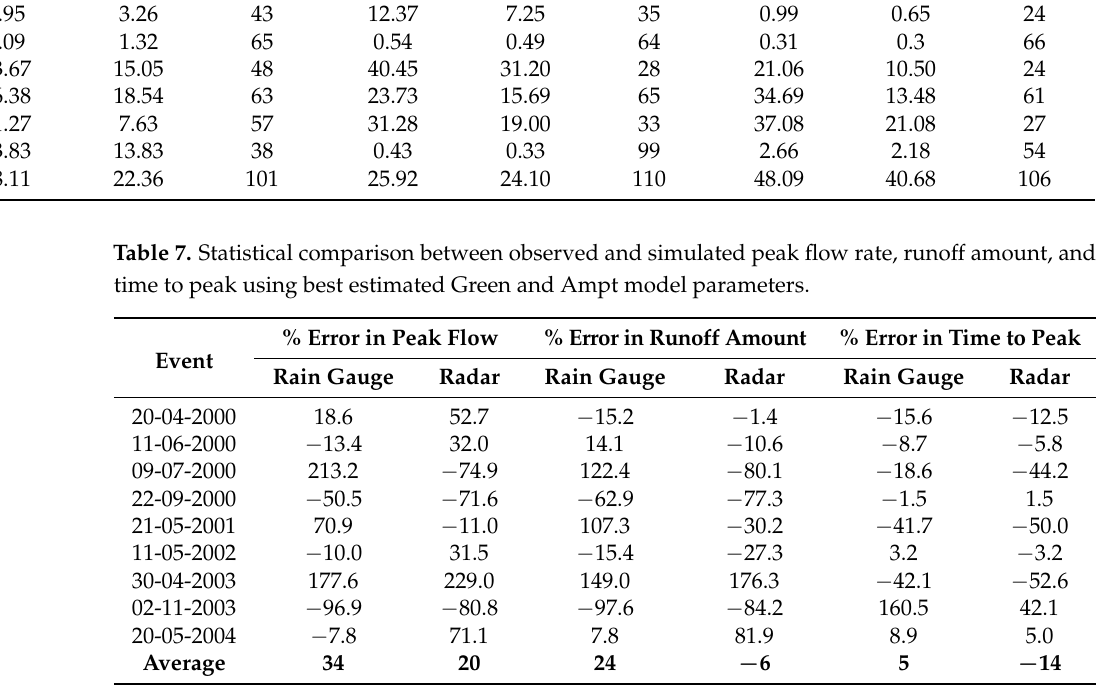
Table 8. Summary of observed and simulated peak flow rate, runoff amount, and time to peak ob- tained using calibrated Green and Ampt model parameters with rain gauge and radar rainfall